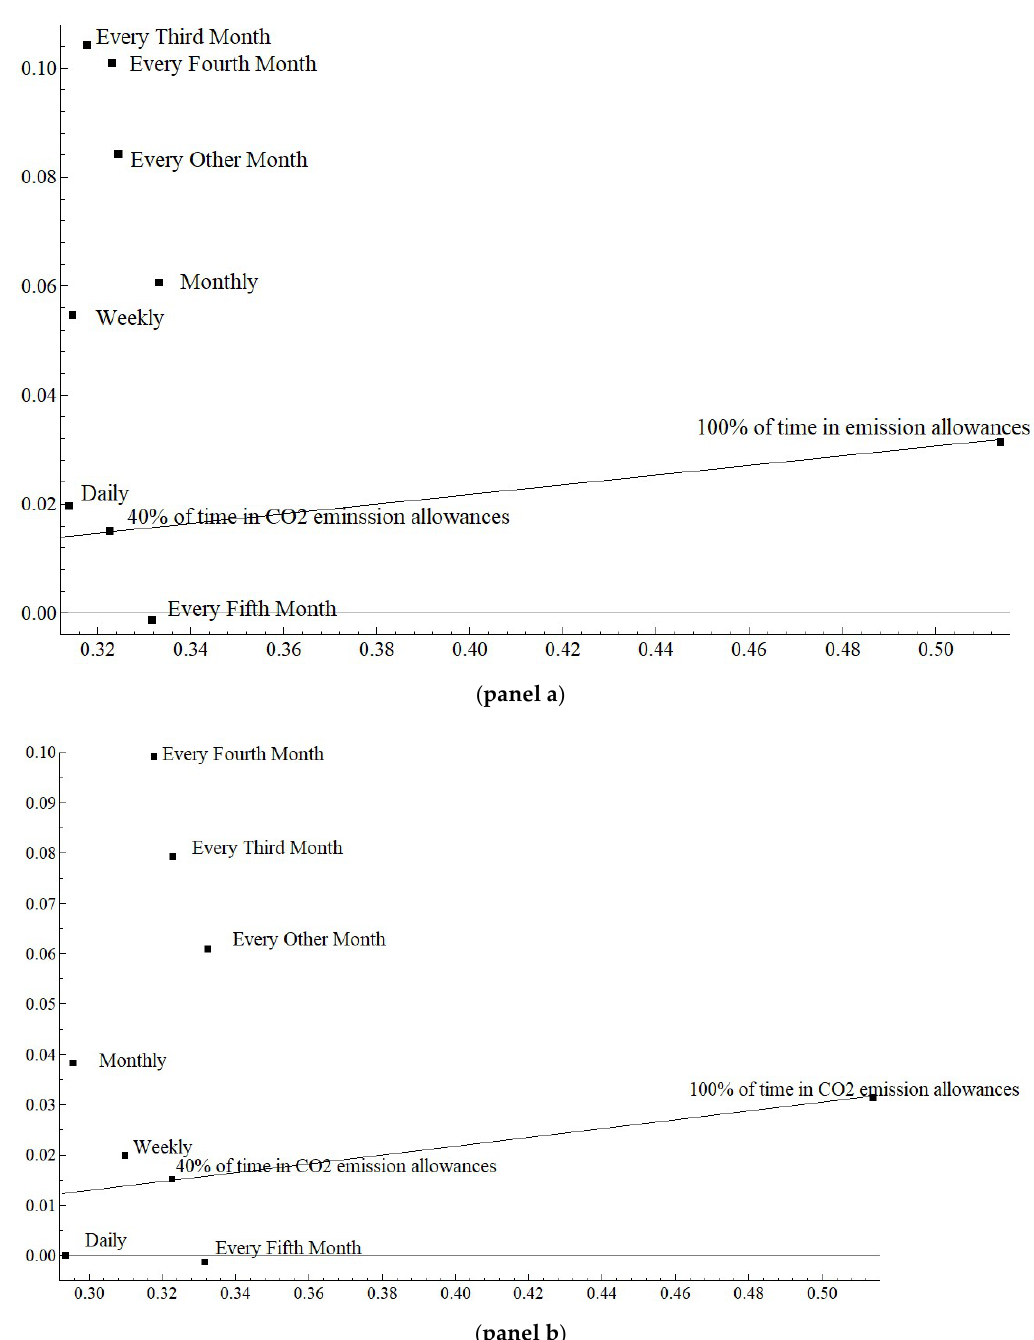
Figure 4. Returns to volatility ratios in CO 2 emission spots, 19 January 2009 to 28 September 2018, compared with random timing. ( panel a ) Calculated daily, weekly, monthly, every second month, every third month, every fourth month, and every fifth month; ( panel b ) Calculated with maximal rolling window, daily (MA200), weekly (MAW40), monthly (MA10), every second month (MAD5), every third month (MAT4), every fourth month (MAQ3), and every fifth month (MAC2). Panel b of Figure 4 shows the MA results when the last 200 trading days, the last 40 weekly observations, the last 10 monthly observations, the last five of every other month observations, the last four of every third month observations, the last three of every fourth month observations, and the last two of every fifth month observations, are used. From the panel, one can see that all but every fifth month and daily frequencies produce a better performance than does theoretical random timing.